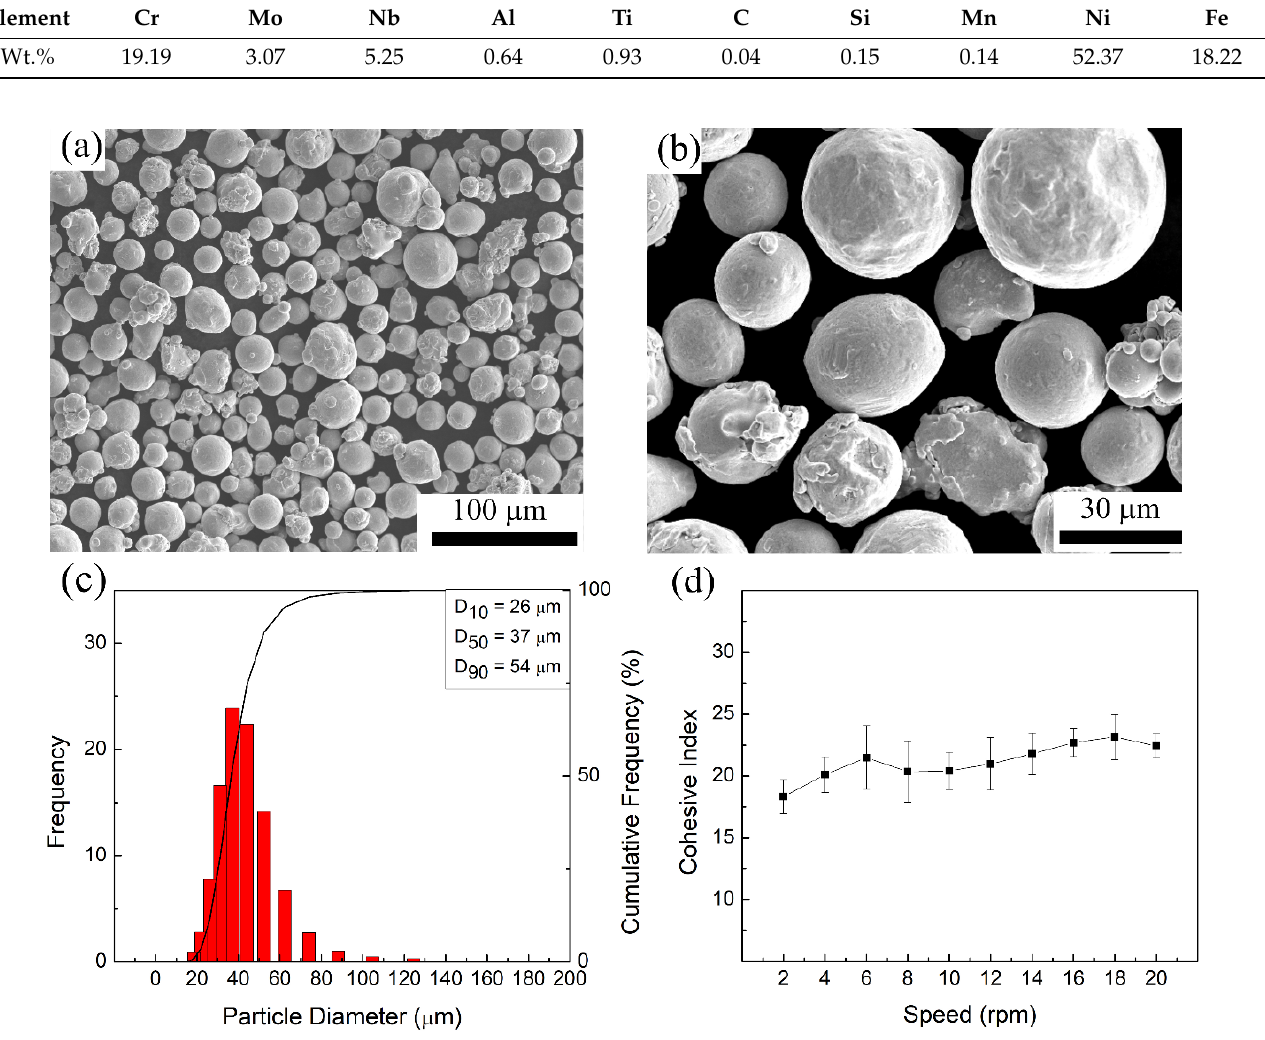
Figure 1. ( a , b ) Morphology, ( c ) particle size distribution, and ( d ) cohesive index of the starting IN718 powder.